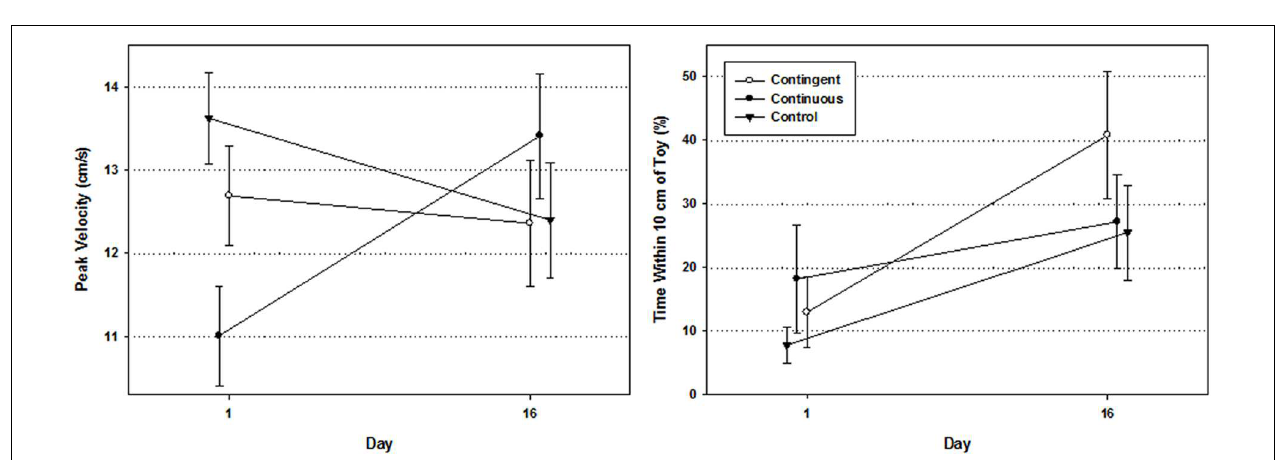
FIGURE 6 | (Left) Mean peak velocity of the preferred reaching hand by group. (Right) Mean percent of time that preferred reaching hand was within 10 cm of the